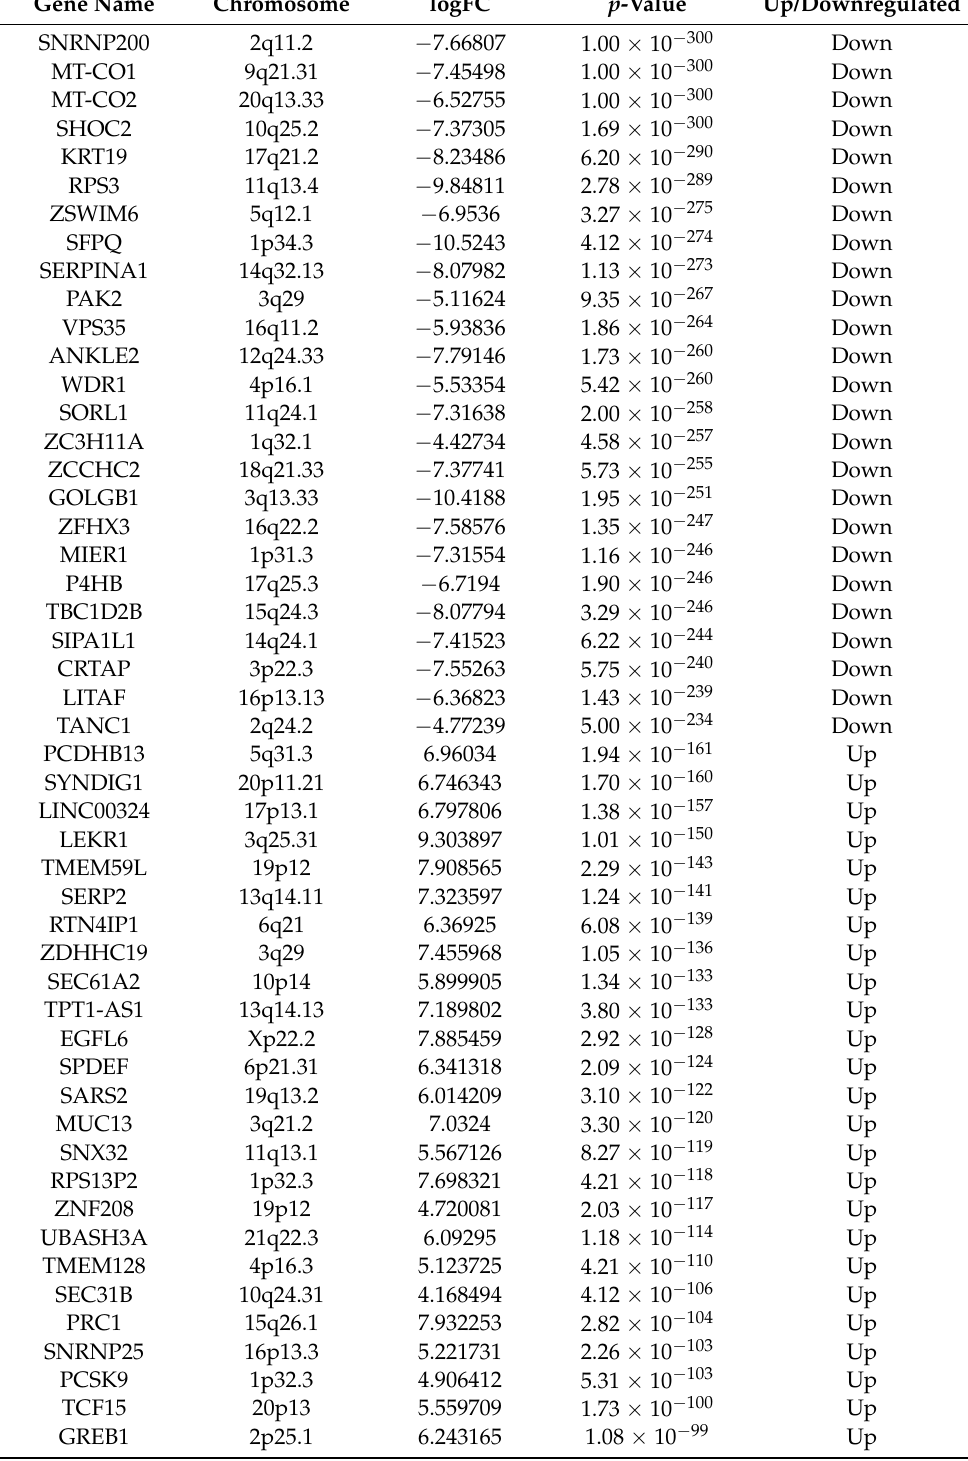
Table 1. Top 25 upregulated and top 25 downregulated differentially expressed genes between COVID-19 and lung cancer tumors and their estimates of p -values and